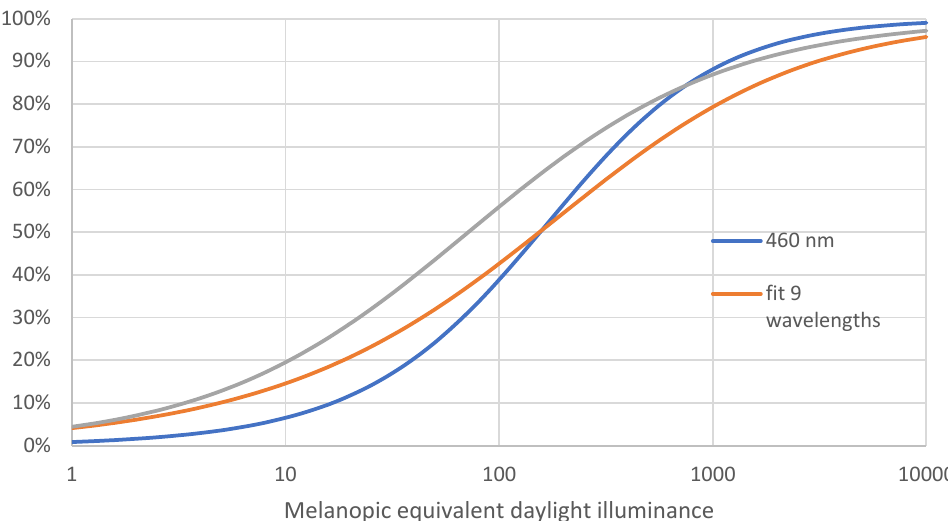
Figure A1. Normalized nighttime melatonin suppression for non-dilated pupils as a function of melanopic equivalent daylight illuminance. The half-maximum is at 71.6 lux for a 6500 K fluorescent illumination, 155.3 lux for 460 nm illumination, and 154 lux for the 9 wavelength fit. The normalization is relative to the dark response and maximal light response to eliminate the difference in measurement methods, test conditions and intra-group differences.